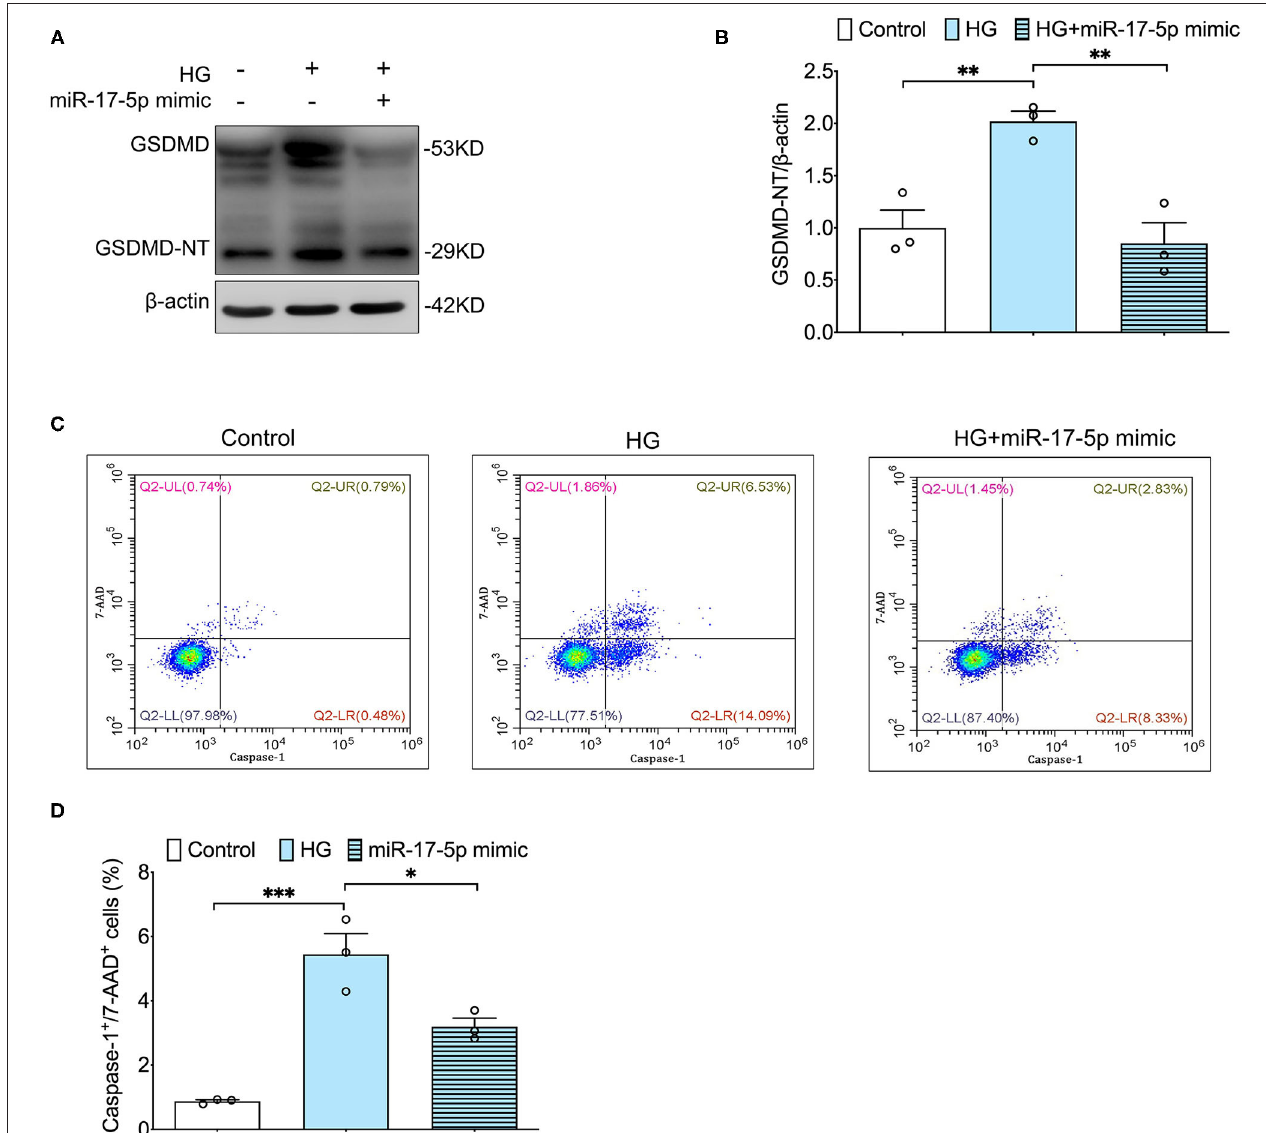
FIGURE 3 | MiR-17-5p mimic inhibited high glucose-induced pyroptosis in INS-1 cells. (A,B) Representative blots and quantitative analysis showing the expression of cleavage of GSDMD in INS-1 cells. (C,D) Representative flow cytometric dot plots and the corresponding quantification showing active caspase-1 + /7-AAD + cells as pyroptosis population in INS-1 cell cultured with different concentrations of glucose. Control: 5 mmol/L; HG (high glucose): 25 mmol/L. * p < 0.05, ** p < 0.01, and *** p <